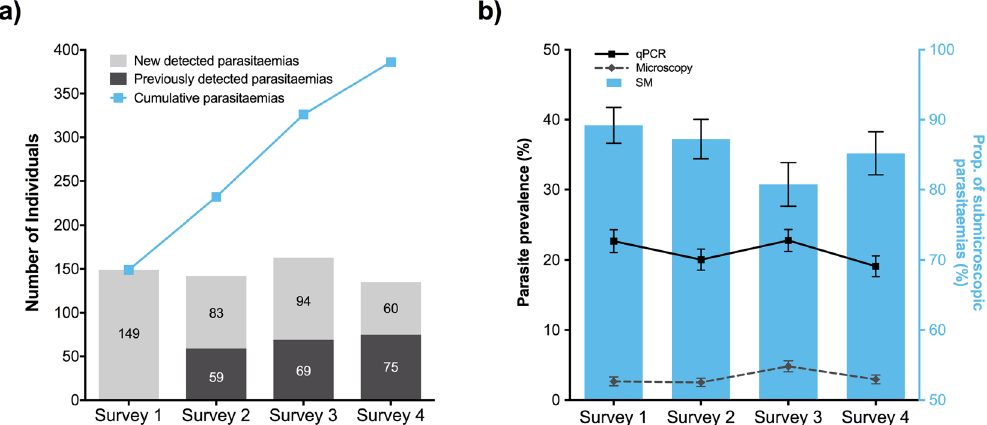
Figure 2. Distribution of P . vivax parasitaemia and parasite prevalence over time (4 ACD surveys): ( a ) Number individuals with new detected (light grey bars), previously detected (dark grey bars) and cumulative (light blue squares) P . vivax parasitaemia, and ( b ) P . vivax parasite prevalence by microscopy (grey dashed line), and qPCR (black solid line), and the proportion of submicroscopic parasitaemia (SM, light blue bars) in each survey round. Error bars represent the standard error of the proportion (SEP) in each survey round. Surveys were conducted from May to July 2015, with 10 days between